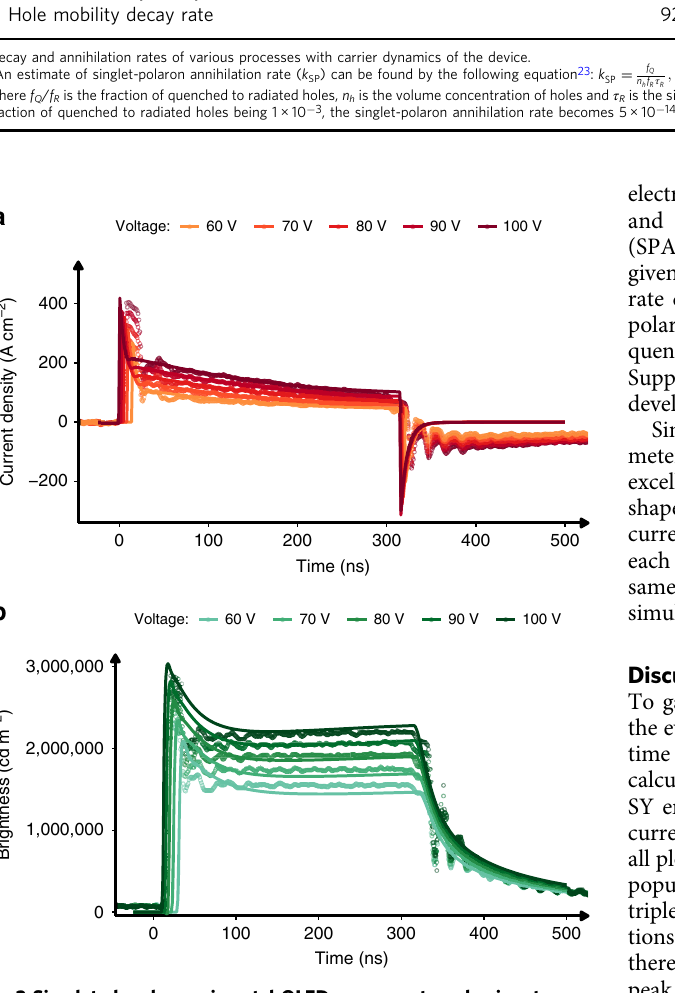
Fig. 2 Simulated and experimental OLED response to pulse input. a Current. b Brightness. Simulated and experimental response of the OLED subjected to the 300-ns voltage pulses with amplitudes varying from 60 to 100